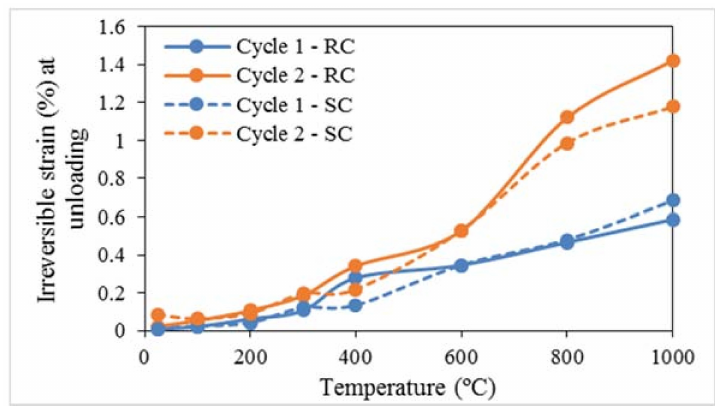
Figure 13. Irreversible strain experienced in rock specimens after cycle 1 and cycle 2.